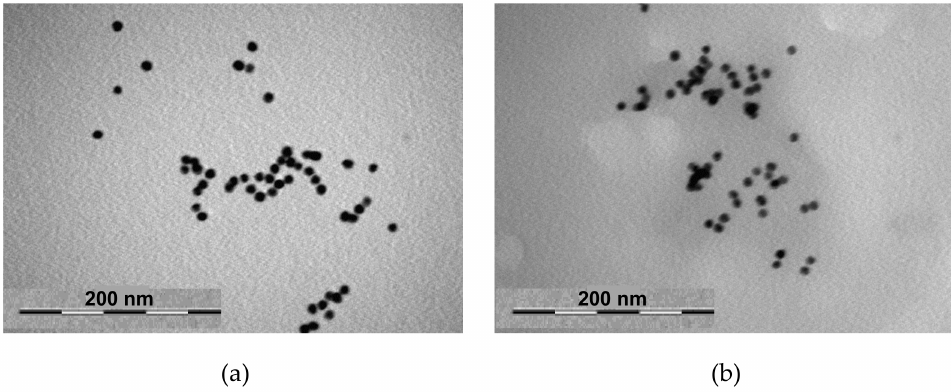
Figure 7. TEM images of the nanocomposite (AuNPs + Cop-48/6): ( a ) I = 0 M, ( b ) I = 0.75 M.